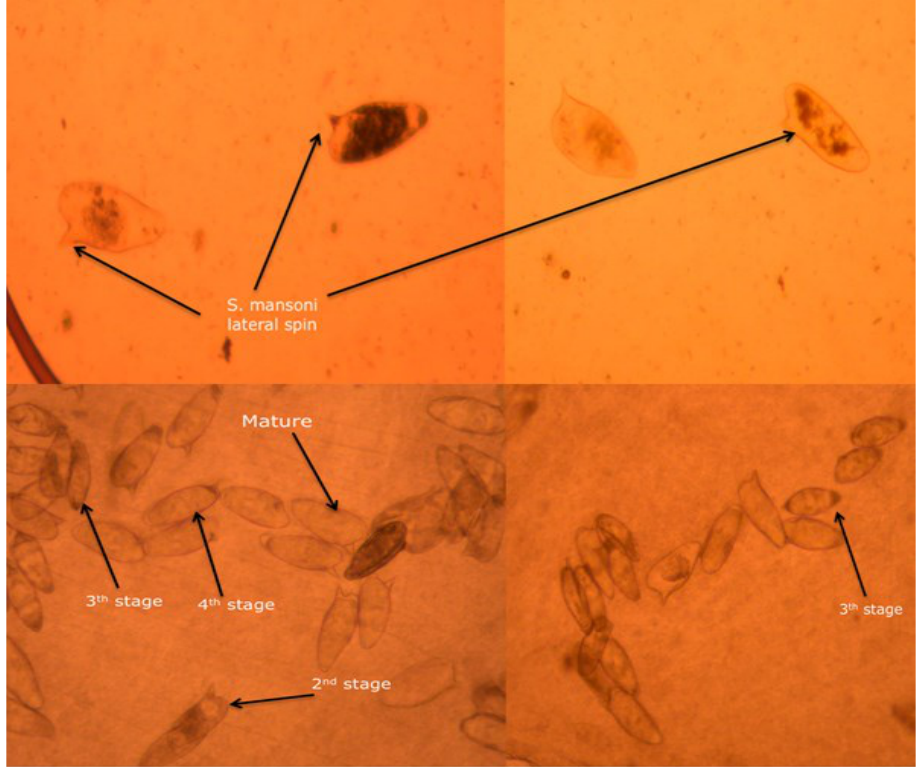
Figure 12. Typical imaging of S. mansoni eggs count at different stages of maturity in the small intestine of infected mice, visualized with the aid of a light microscope (×40 magnification). Table 1. Effect of PZQ and anti-calpain-NLP (single dose 250 mg/kg two weeks post infection) on worm load and sex in S. mansoni -infected mice sacrificed six weeks post infection.